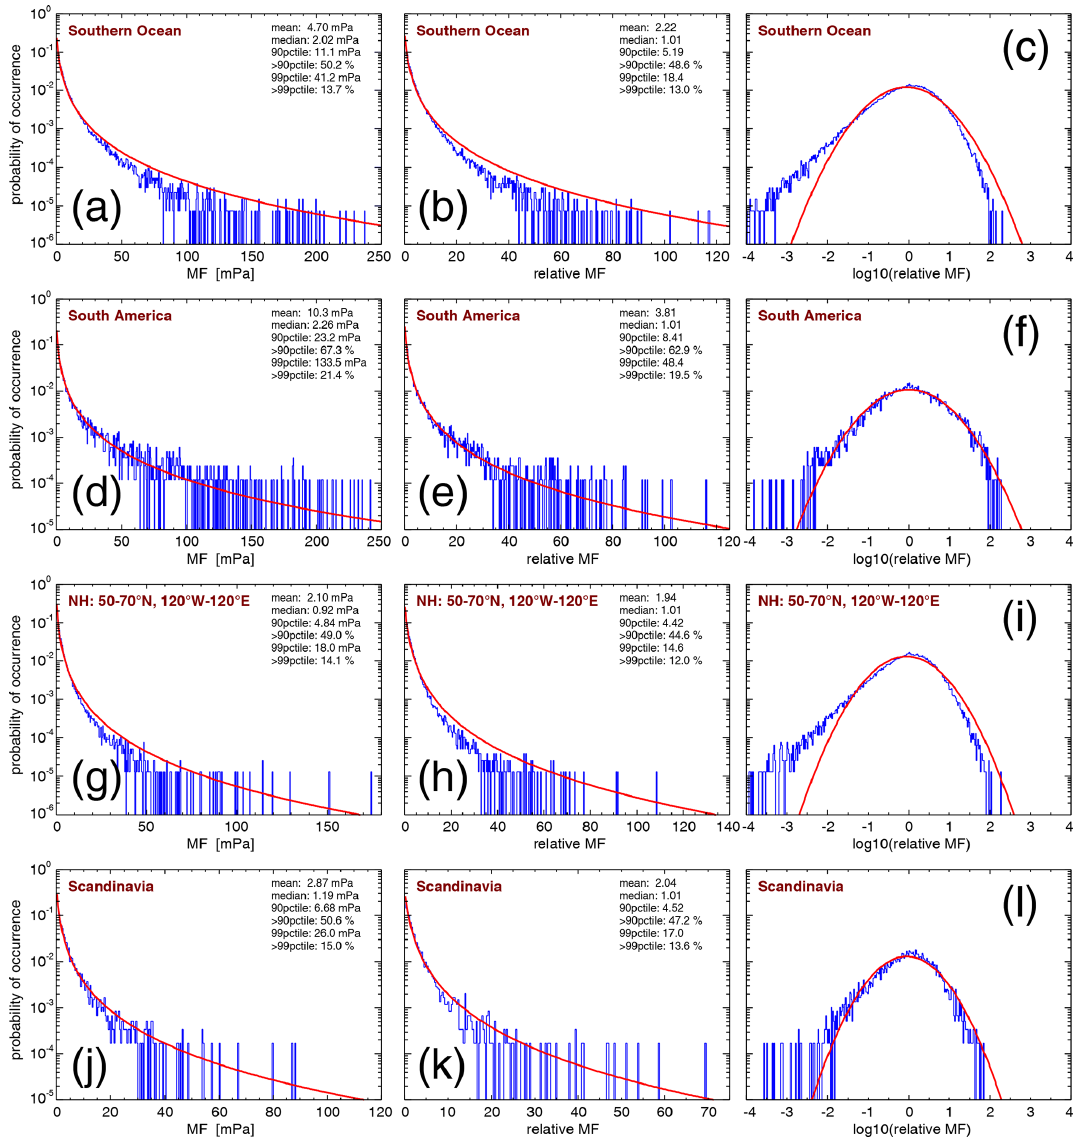
Figure 8. PDFs of HIRDLS gravity wave absolute momentum fluxes (MF) at 30km altitude for the Southern Ocean during austral winter (JJA) ( a – c ), for the region of the gravity wave hot spot over South America during austral winter (JJA) ( d – f ), for the region of enhanced gravity wave activity in the Northern Hemisphere polar night jet during boreal winter (DJF) ( g – i ), and for Scandinavia and its close vicinity during boreal winter (DJF) ( j – l ). For an illustration of the locations of the different regions, see Fig. 5. Panels (a) , (d) , (g) , and (j) show gravity wave absolute momentum flux in millipascals (mPa), whereas the remaining panels show relative momentum